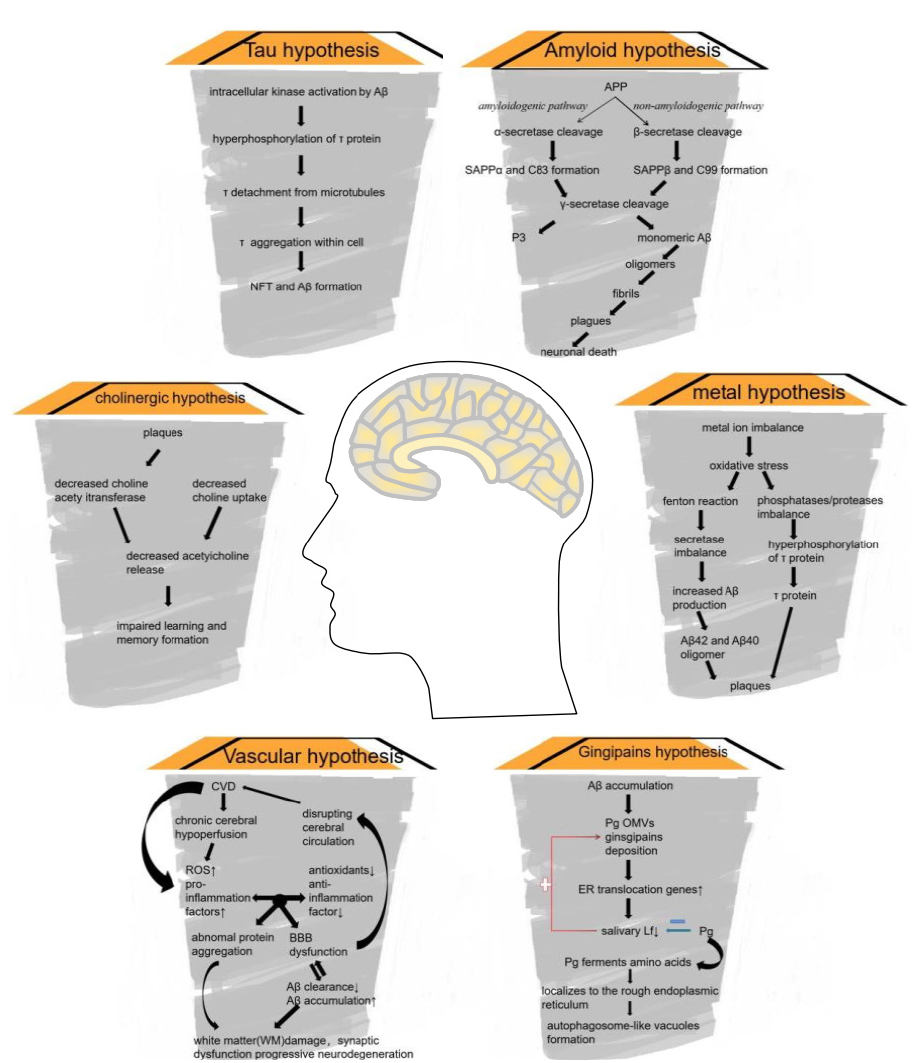
Figure 1. Multiple hypotheses are involved in Alzheimer’s disease (AD)